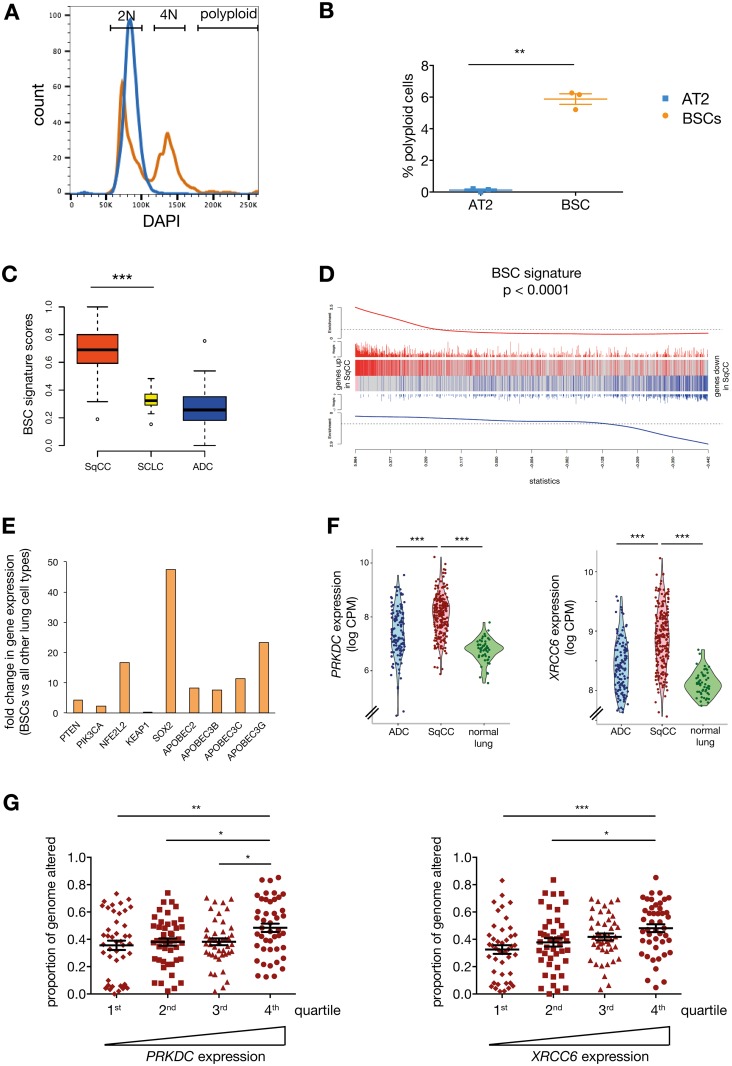
Human lung BSCs are the putative cells of origin of lung squamous cell carcinoma.(A) Representative histogram of intracellular DAPI staining of BSCs and AT2 cells isolated from a 56-y-old male exsmoker patient. Gates indicate 2N, 4N, and polyploid cells. (B) Proportion of polyploidy cells in the BSC and AT2 subsets. n = 3 patients (a 69-y-old female exsmoker, a 56-y-old male exsmoker, and a 70-y-old female exsmoker). Paired t test. (C) Boxplots of human lung BSC expression scores by lung tumour subtypes (ADC, adenocarcinoma; SCLC, small cell lung cancer; SqCC, squamous cell carcinoma). The width of each box indicates the sample size. (D) Barcode plot showing strong correlation of the human lung BSC expression signature with that of SqCCs (ROAST p = 0.0001). Genes are sorted left to right from most up- to most down-regulated in SqCC relative to all other cancer subtypes. Positive BSC signature genes are marked with vertical red bars, and negative signatures genes are marked in blue. Variable-height bars show log-fold-change strength for each signature gene. (E) Fold changes in the expression of genes frequently altered in lung SqCC between human BSCs and other human lung epithelial cell types. n = 3 patients (a 64-y-old male exsmoker, an 83-y-old male exsmoker, and a 53-y-old male current smoker). (F) Violin plots showing expression levels of PRKDC and XRCC6 in normal lung tissue (n = 54), lung ADCs (n = 125), and lung SqCCs (n = 224) from The Cancer Genome Atlas (TCGA). Violin bodies show log2 counts per million (log CPM) expression values as smoothed densities. All pairwise p-values are <10−6 by moderated t tests. (G) Proportion of genome altered versus PRKDC and XRCC6 expression levels in TCGA lung SqCC data (n = 179). Expression levels are split into quartiles. Significance was determined by Student’s t tests. The underlying data for panels A, B, C, D, E, and G can be found in the S1 Data file.